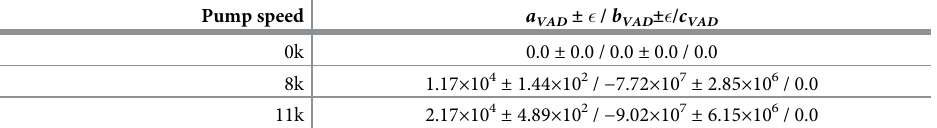
Table 1. Fitting coefficients ( a speed is measured in [ rpm ]. The units are a VAD [Pa], b VAD [Pa � s/m 3 ], and c VAD [Pa � s 2 /m 6